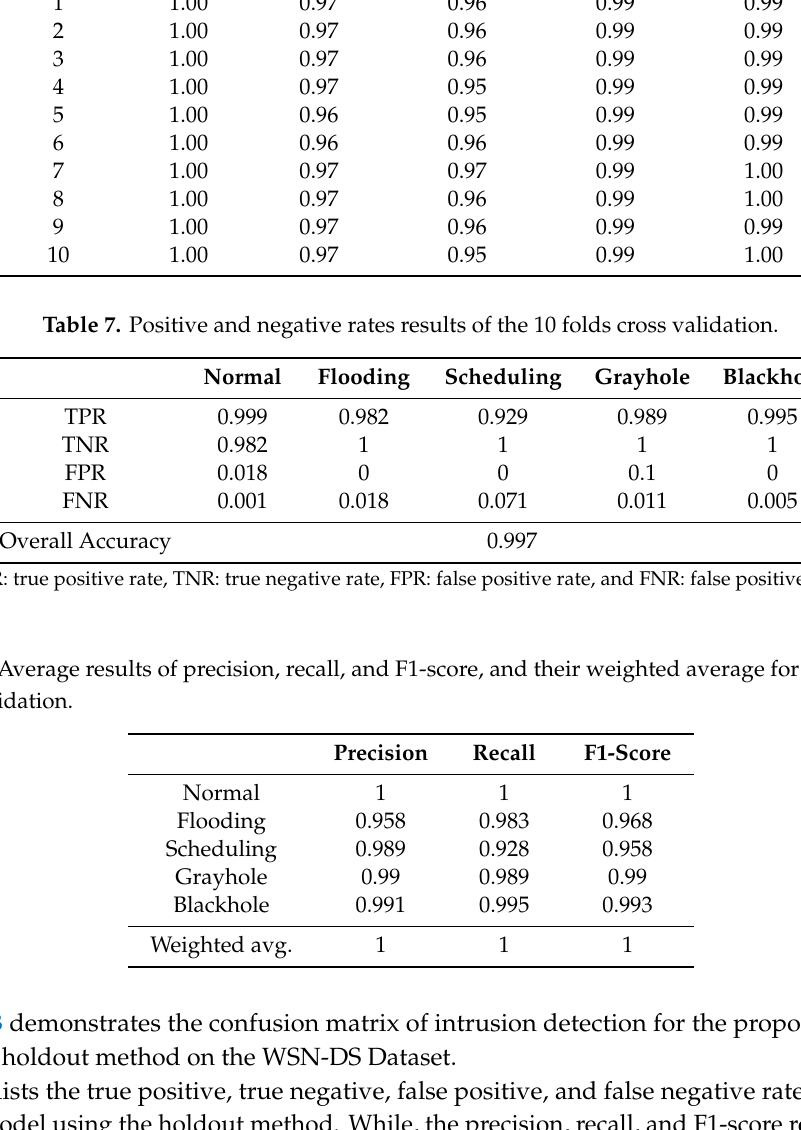
Table 9 lists the true positive, true negative, false positive, and false negative rates results of the GXGBoost model using the holdout method. While, the precision, recall, and F1-score results and their weighted average using the holdout method are shown in Table